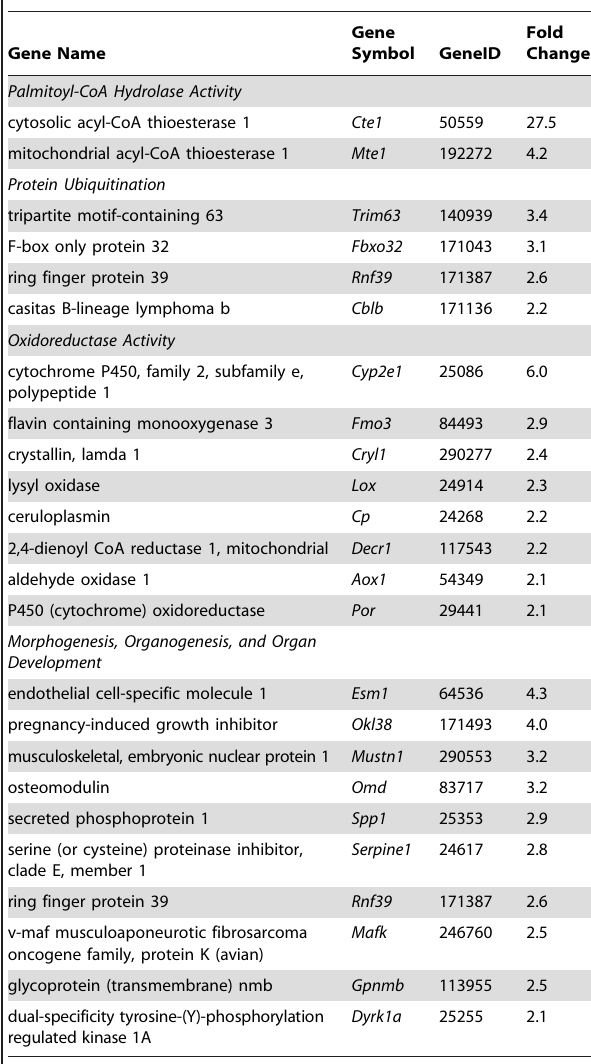
Table 2. Genes with $ 2-fold increased expression in diabetic diaphragm assigned to over-represented gene ontology